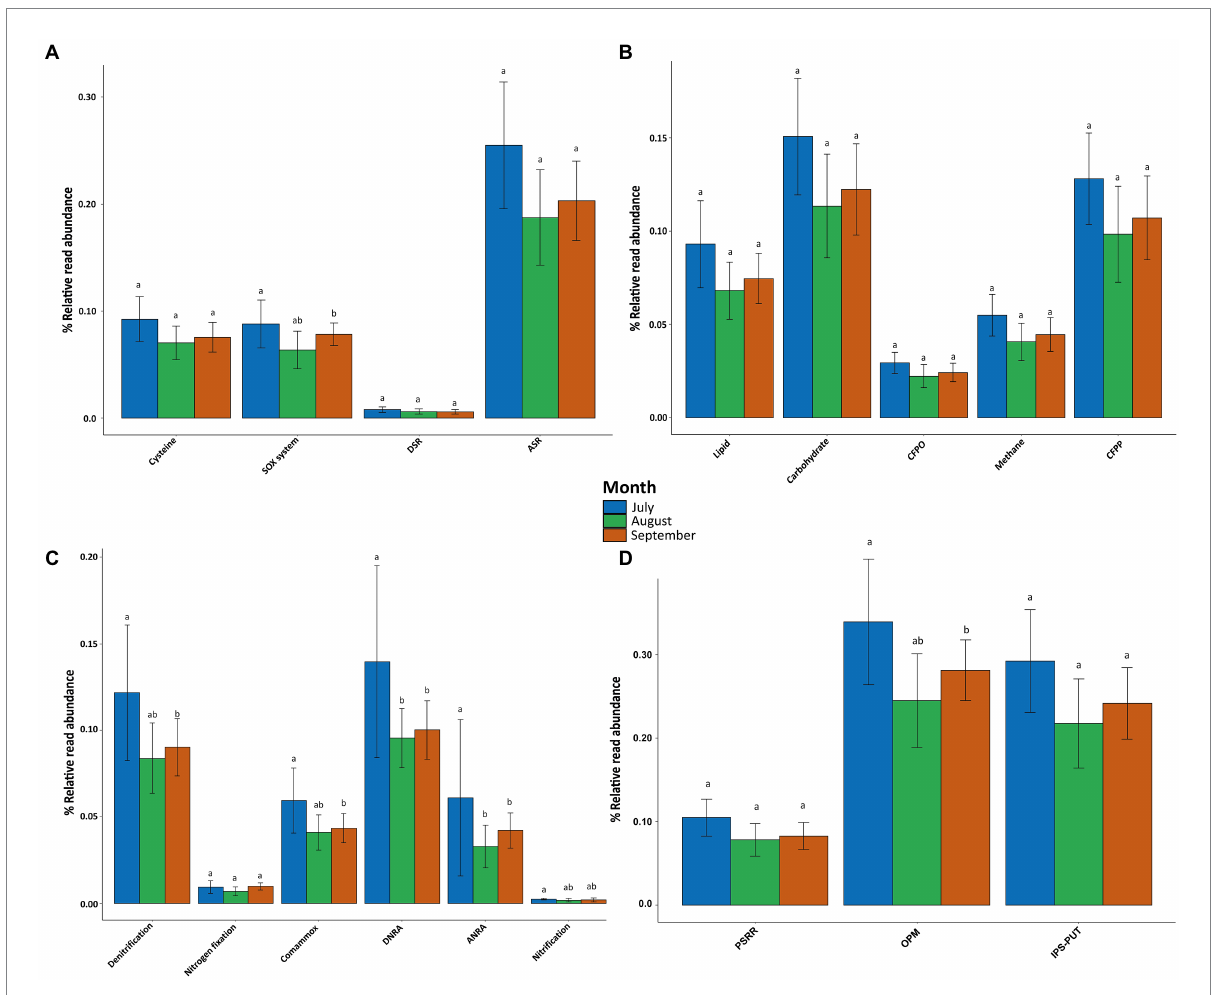
FIGURE 6 Relative read abundance of genes associated with major pathways in (A) Sulfur metabolism–ASR, assimilatory sulfate reduction; DSR, dissimilatory sulfate reduction; SOX system, sulfur oxidation system. (B) Central carbon metabolism–CFPP, carbon fixation pathways in prokaryotes; CFPO, carbon fixation in photosynthetic organisms. (C) Nitrogen metabolism–DNRA, dissimilatory nitrate reduction to ammonia; ANRA, assimilatory nitrate reduction to ammonia. (D) Phosphorus cycle–IPS-PUT, Inorganic P solubilization and P uptake and transport; OPM, organic P-mineralization; PSRR, P-starvation response regulation. Different letters indicate significant differences within a single